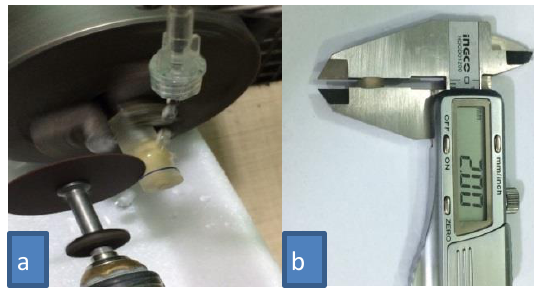
Figure 5: a. Sectioning of the specimen, b.